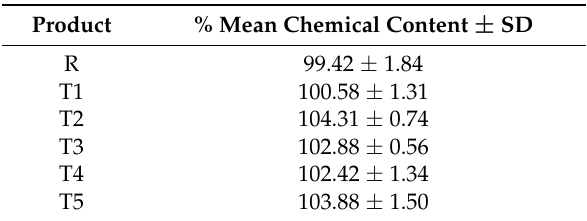
Table 3. Mean percent of amoxicillin in each tested tablet product calculated on the basis of claimed amount ± standard deviation (SD).